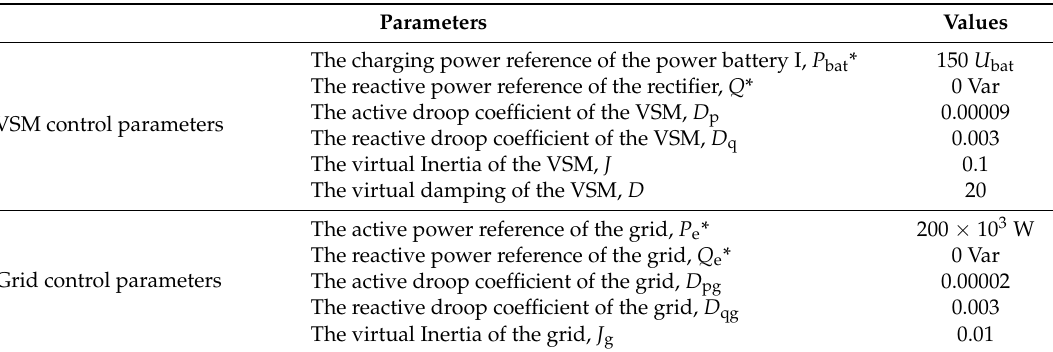
Table 2. Control parameters of the VSM and